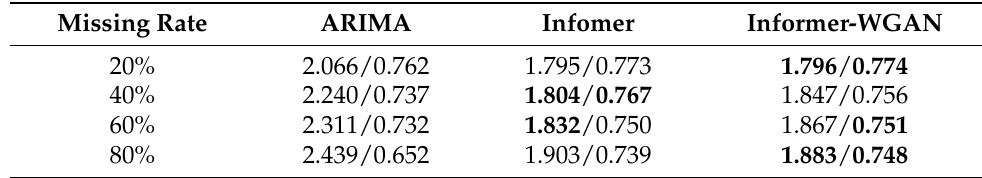
Table 9. The RMSE/Pearson correlation results of the informer-WGAN and other imputation results on ETTh1 dataset.